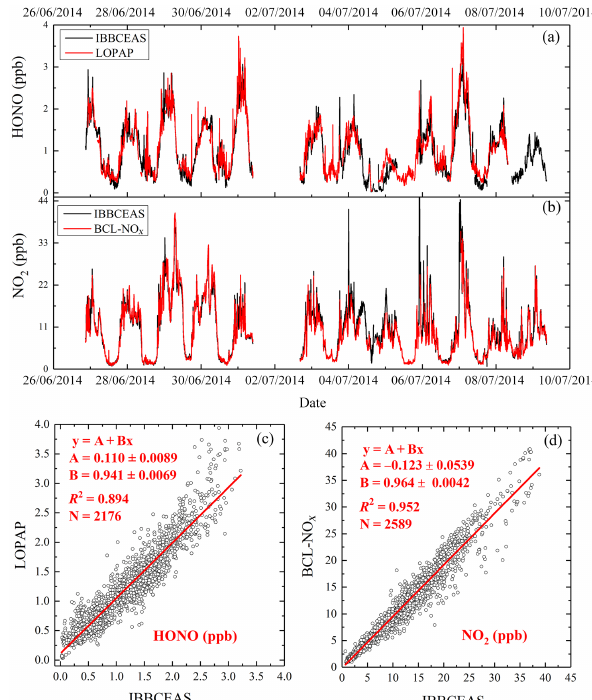
Figure 10. (a) Time series of HONO measured by the IBBCEAS instrument and LOPAP; (b) time series of NO 2 measured by the IBBCEAS instrument and the BLC-NO x analyzer; (c) correlation plot of the two [HONO] time series (data averaged to 5min base); (d) correlation plot of the two [NO 2 ] time series (data averaged to 5min